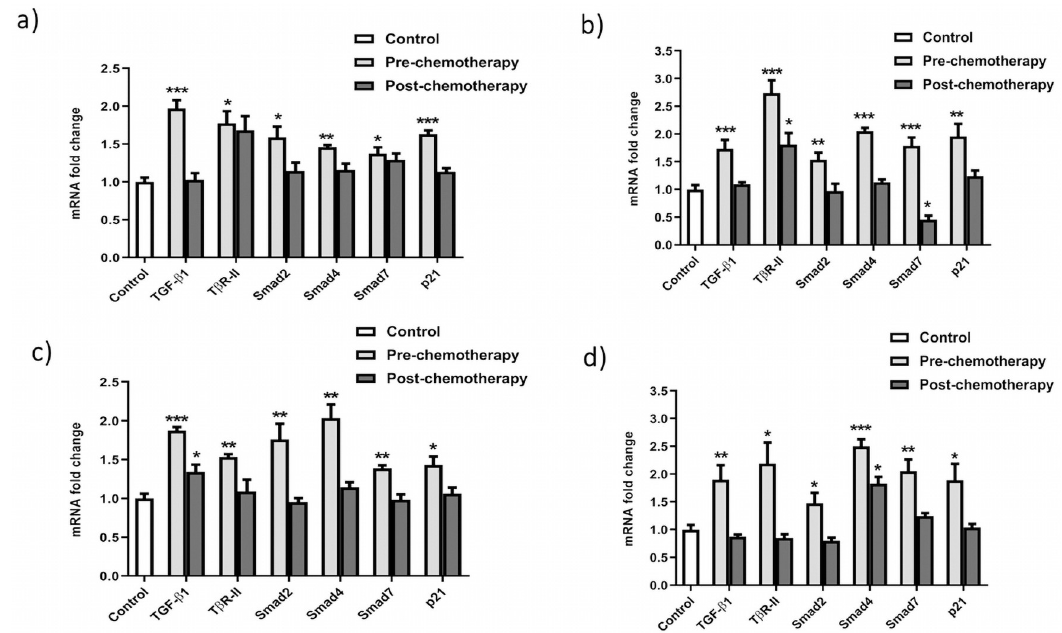
Fig 4. TGF- β cascade expression profiling in a) G-II blood samples b) G-II biopsy samples c) G-III blood samples d) G-III biopsy samples. The relative quantification results indicate the expression pattern of TGF- β pathway genes in G-II and GIII breast cancer clinical samples based on chemotherapy status. All the experiments were performed in triplicates. Error bars show ± SD. ANOVA test was applied to the data at � P < 0.05, �� P < 0.001, ��� P <